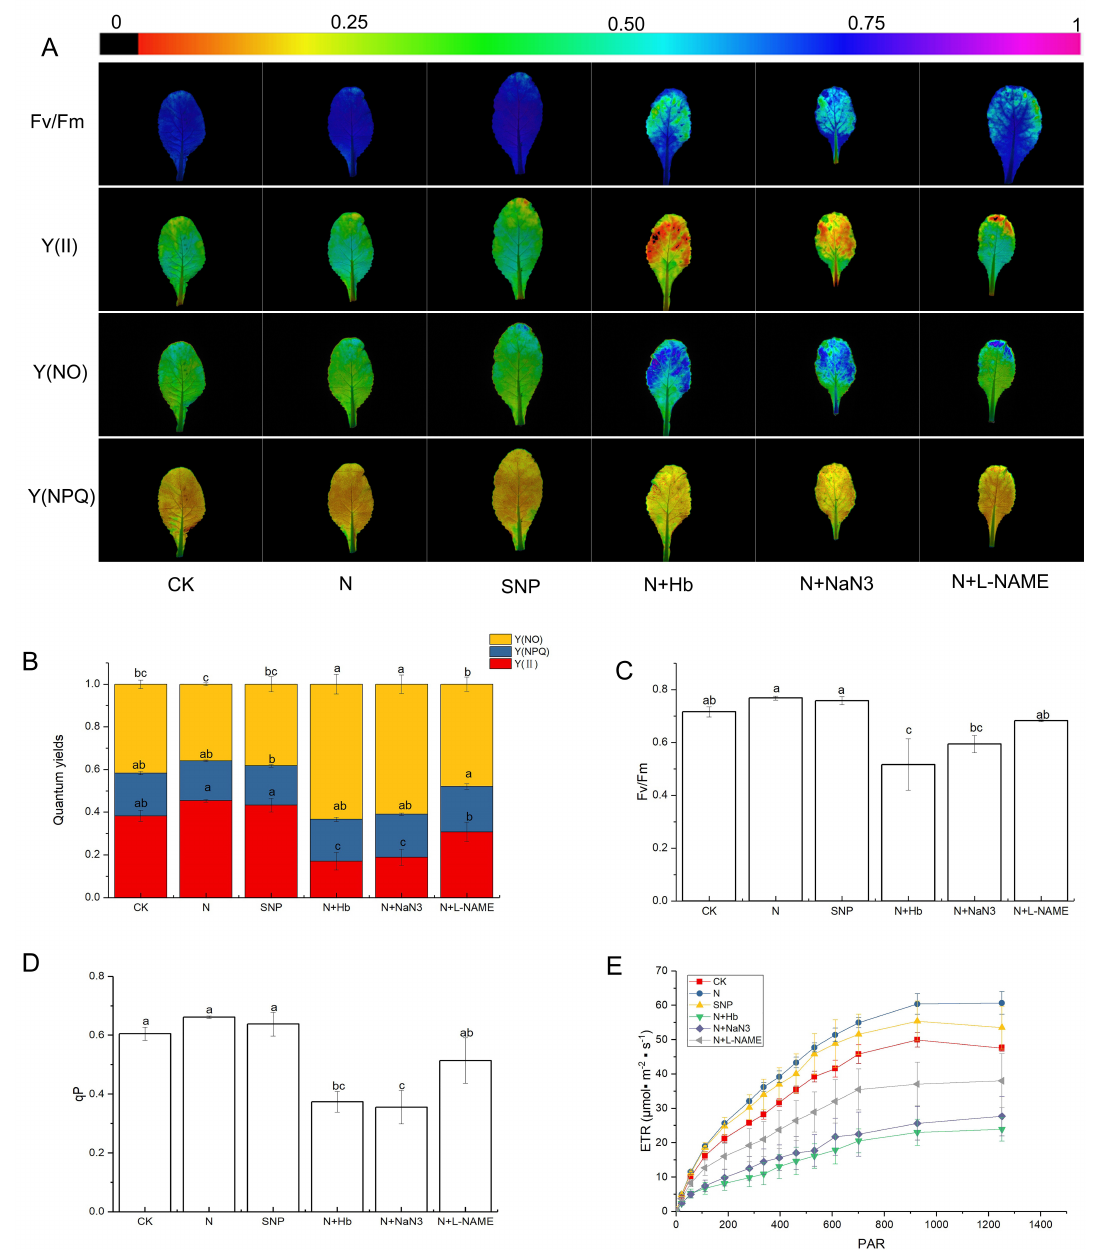
Figure 3. The chlorophyll fluorescence parameters of mini Chinese cabbage seedlings exposed to low − light stress. ( A ) Images of maximal PSII quantum efficiency (Fv/Fm), effective PSII quantum yield Y(II), quantum yield of non − regulated energy dissipation Y(NO), and quantum yield of regulated energy dissipation Y(NPQ) determined on the third leaf of mini Chinese cabbage seedling fertilized with ammonium/nitrate = 0/100 (CK), ammonium/nitrate = 10/90 (N), sodium nitroprusside (SNP), ammonium/nitrate (10/90)+ hemoglobin (N + Hb), ammonium/nitrate (10/90)+ sodium azide (N + NaN 3 ), ammonium/nitrate (10/90) + N ω -nitro-L-arginine methyl ester (N + L-NAME). ( B ) Data of Y(II), Y(NO), and Y(NPQ). ( C ) Data of Fv/Fm. ( D ) Data of qP. ( E ) Data of ETR. Means from three leaves followed by different letters were significantly different ( p ≤ 0.05) according to Tukey’s test. Bars indicated the standard errors of the means ( n =